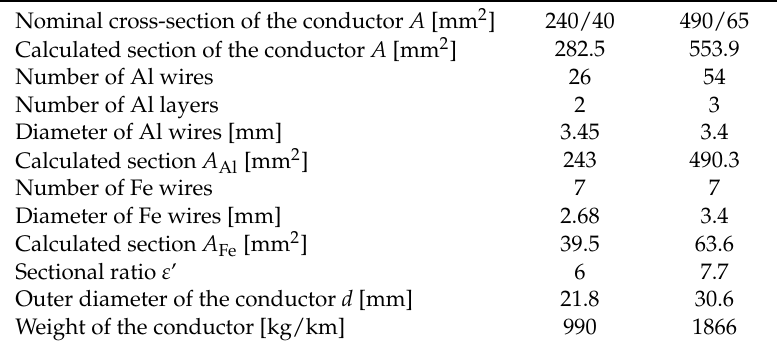
Table 6. Parameters for conductors AlFe 490/65 and AlFe 240/40